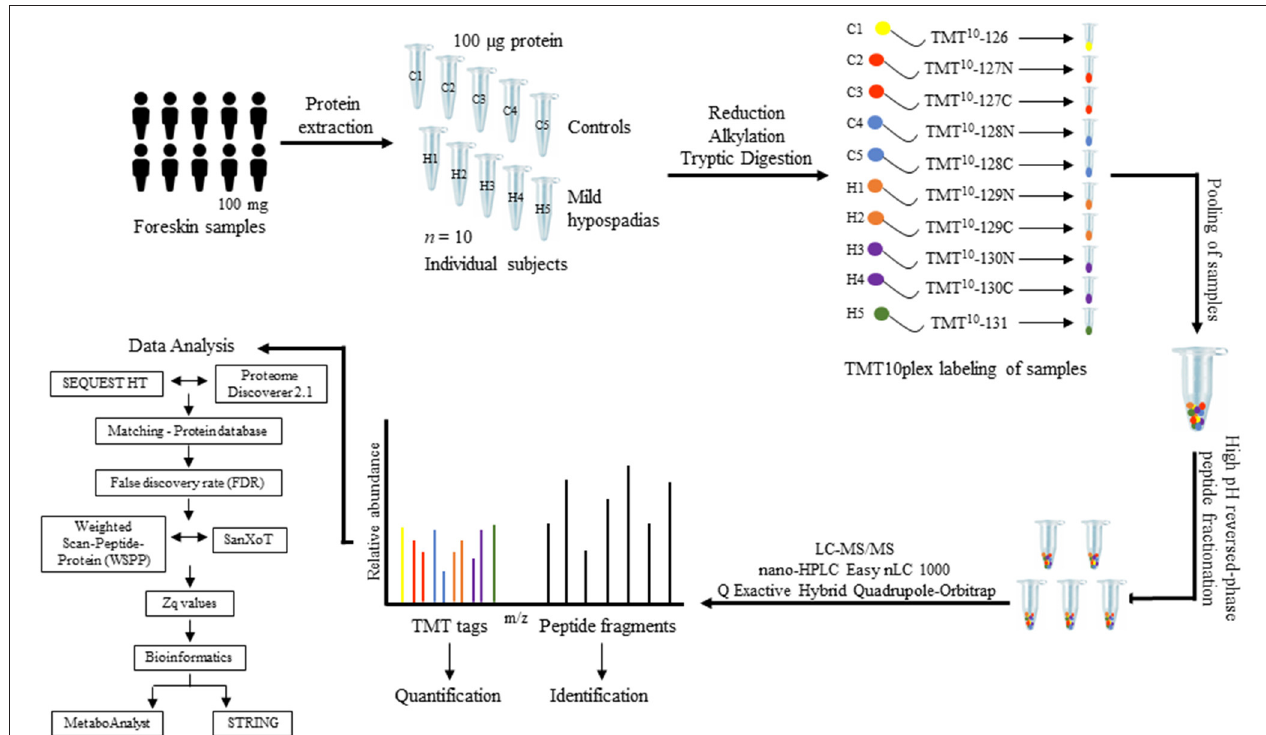
FIGURE 1 | Proteomics study design. Foreskin samples were collected during scheduled urethroplasty from patients with mild hypospadias ( n = 5) or from individuals submitted to a circumcision procedure (control group, n = 5). One-hundred milligrams of foreskin samples from each patient were homogenized and proteins extracted from tissue. A total of 100 µ g of protein was processed per sample. Protein extracts were digested with trypsin using the FASP technology. Subsequently, peptide samples were labeled using a 10-plex TMT kit. Each sample was labeled with a specific TMT mass tag. After labeling, samples were pooled and separated into five fractions using high pH reversed-phase peptide fractionation. Peptides were resuspended in 0.1% formic acid and analyzed by LC-MS/MS. Upon fragmentation, the specific reporter ion released from each of the 10 mass tags shows in the low-mass region of the MS/MS spectrum. The intensity of this reporter ion was used to measure relative peptide abundance levels among samples, from which relative protein abundance between control and mild hypospadias cases was inferred (see text for